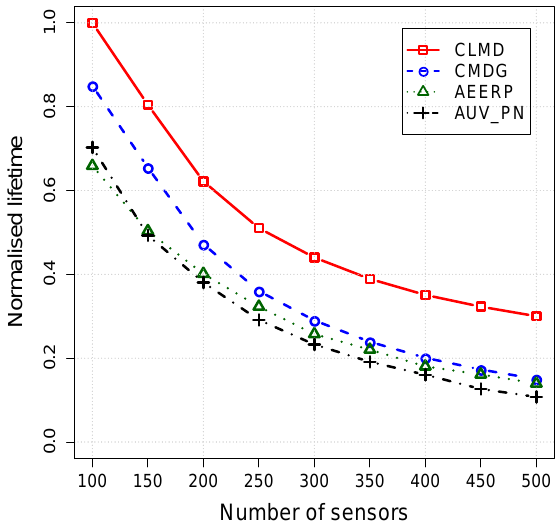
Figure 6. Network lifetime vs. node